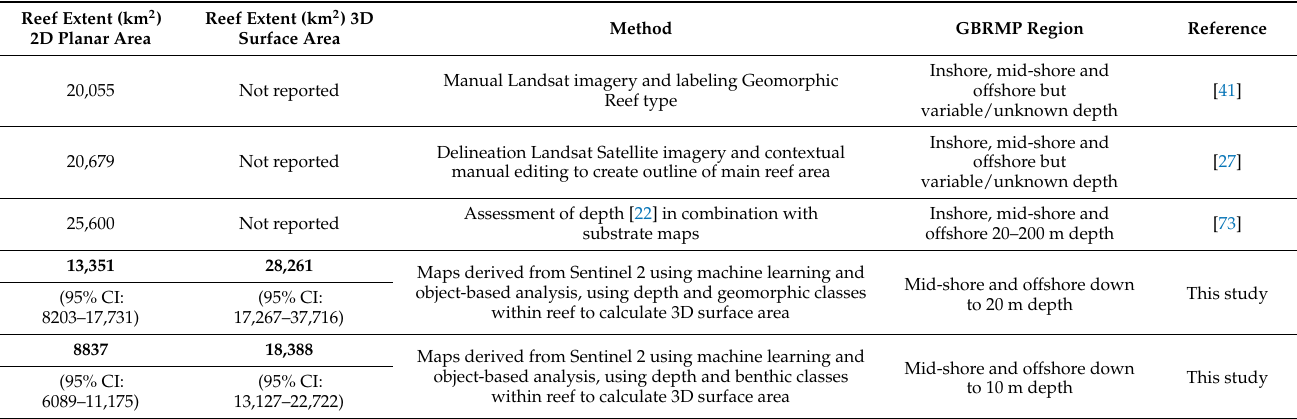
Table 1. Comparison of available reef extent estimates for the Great Barrier Reef Marine Park (GBRMP). Confidence intervals (95% CI) are provided for this